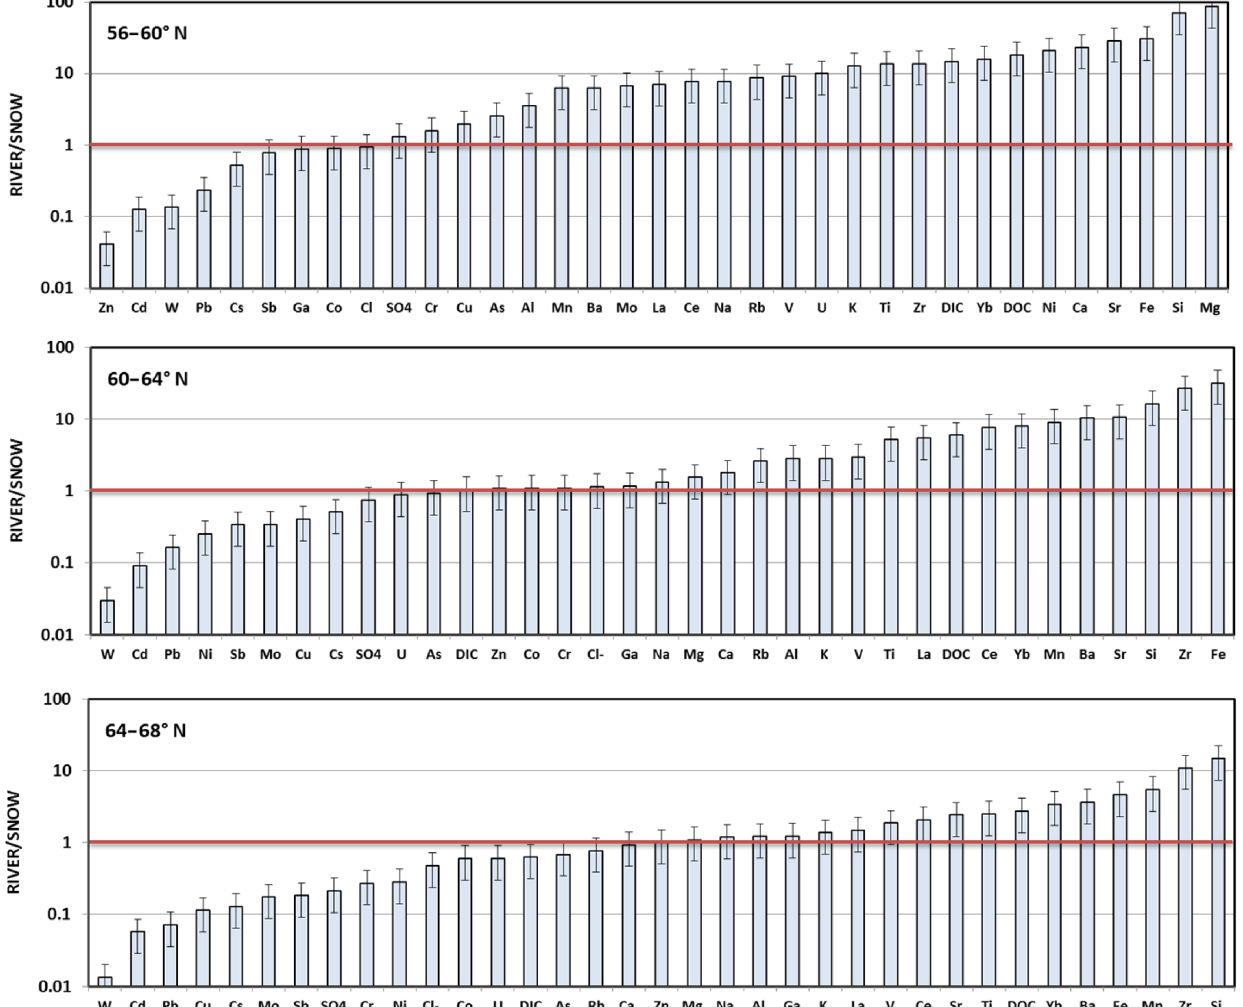
Figure 7. The ratio of mean dissolved flux of rivers in three latitudinal zones (56–60, 60–64, and 64–68 ◦ N) of the WSL to the stock of dissolved fraction of snow. For this calculation, the snow volume (in millimeters of water) accumulated over full winter and mean river runoff over May and June were used. The impact of snowmelt on river export fluxes in spring strongly increases northward for DIC, Cl − , SO 2 − , Na, Mg, Ca, Cr, Ni, Mo, Rb and U, whereas Cd, Pb, Sb, Cu, As, W and Cs present a high impact of snowmelt water on river for the 4 three latitude